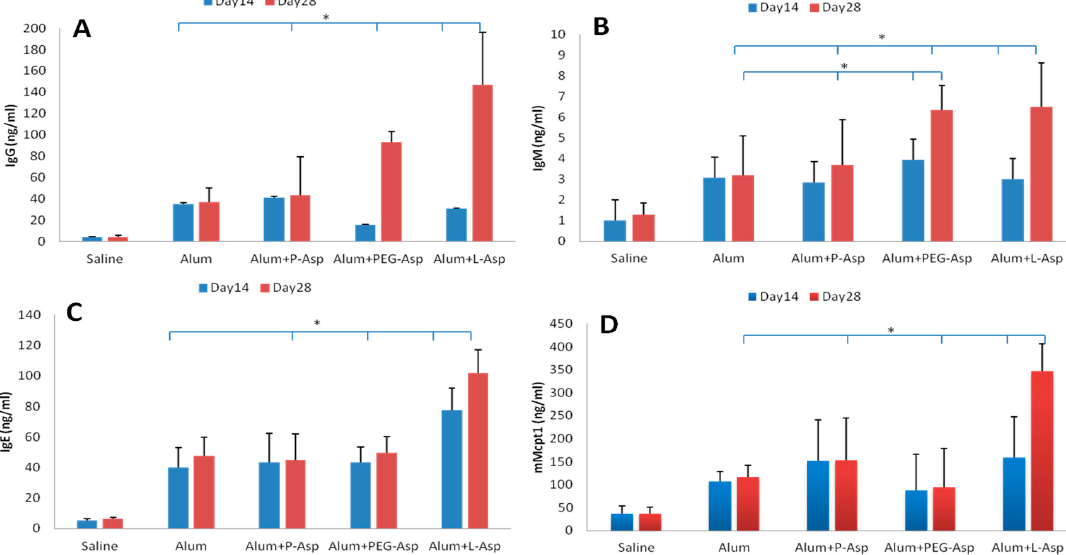
Figure 4. Analysis of immunogenic responses in Balb/c mice treated with Alum plus 50 and 100 IU/mg protein of either P-ASP, L-Asp or PEG-Asp at day 14 and day 28 respectively post initial sensitization with Alum. ( A ) Presents serum IgG levels; ( B ) Presents serum IgM levels; ( C ) Presents IgE in serum and ( D ) presents levels of mMCP-1 in serum. Data represent the average and error bars represents standard deviation. * Statistically significant at p < 0.05 (One-way ANOVA with Dunnett’s test).